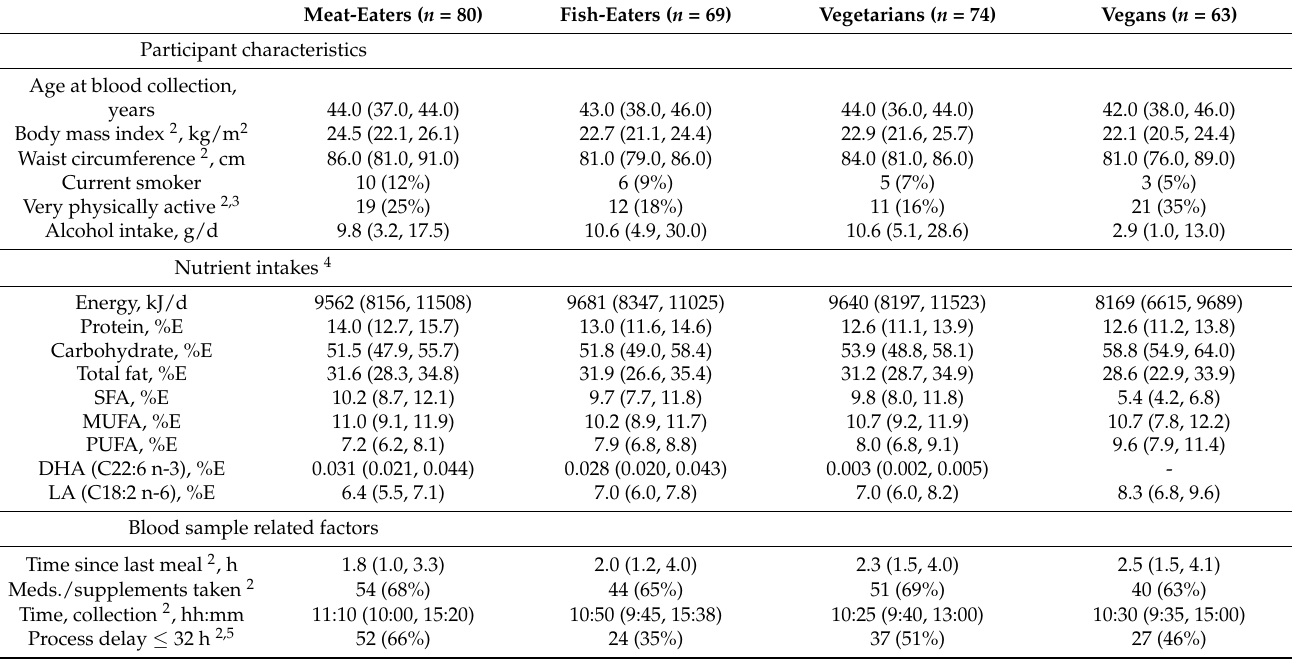
Table 1. Participant characteristics, nutrient intakes and factors related to blood collection and handling by diet group 1